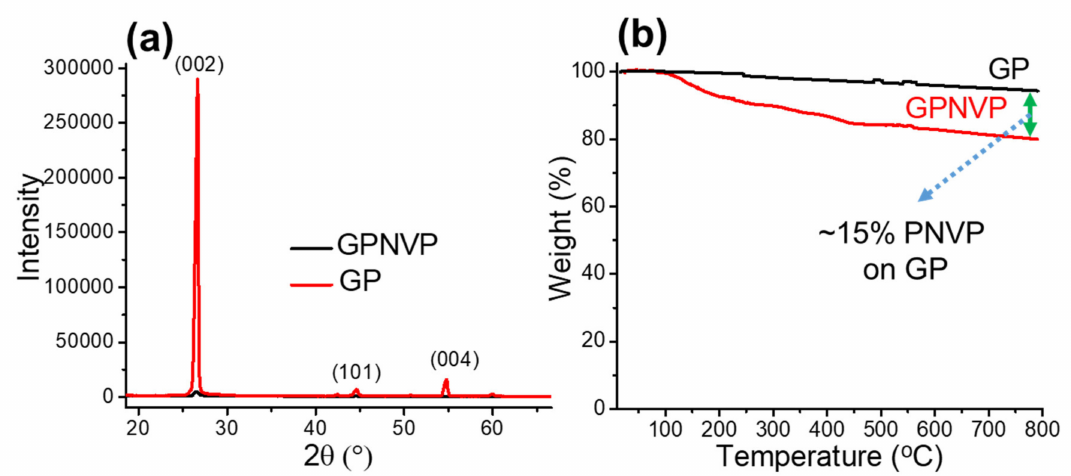
Figure 6. ( a ) XRD patterns and ( b ) TGA curves of GP and GPNVP composite under N 2 atmosphere.